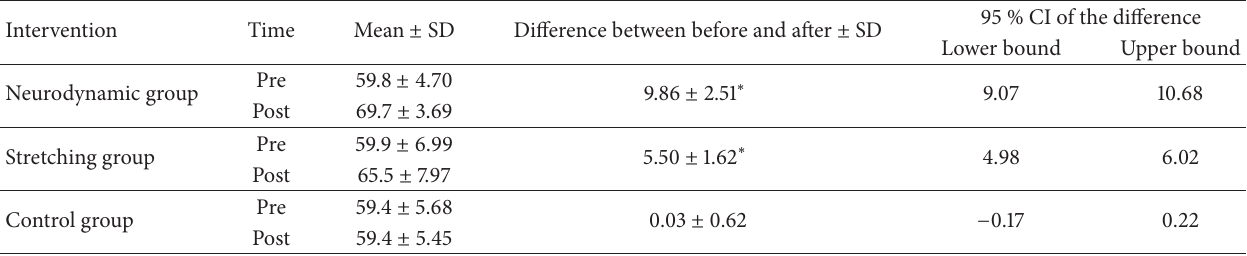
Table 2: Mean passive straight leg raise test (SLR) values pre- and postintervention for each of the 3 groups with associated standard deviations, mean differences over time, and associated 95% confidence intervals